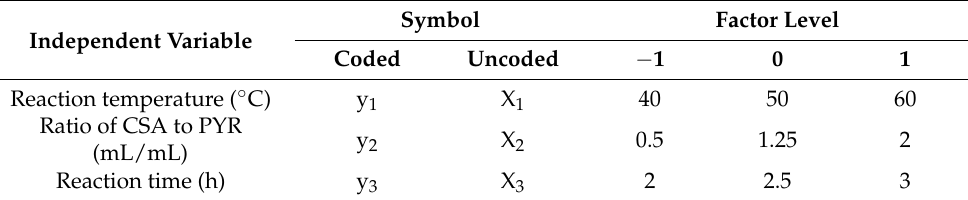
Table 1. Independent variables and their levels used in the response surface design. Symbol Factor Level Independent Variable Coded Uncoded − 1 0 Reaction temperature ( ◦ C) y 1 Ratio of CSA to PYR